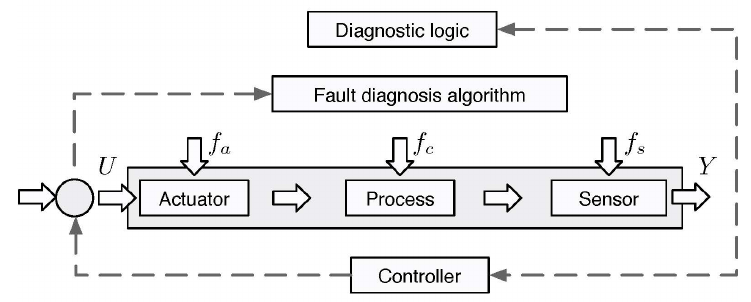
Figure 3. Fault diagnosis